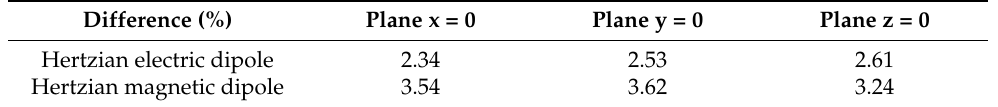
Table 2. Induced electric field comparisons from Hertzian dipole